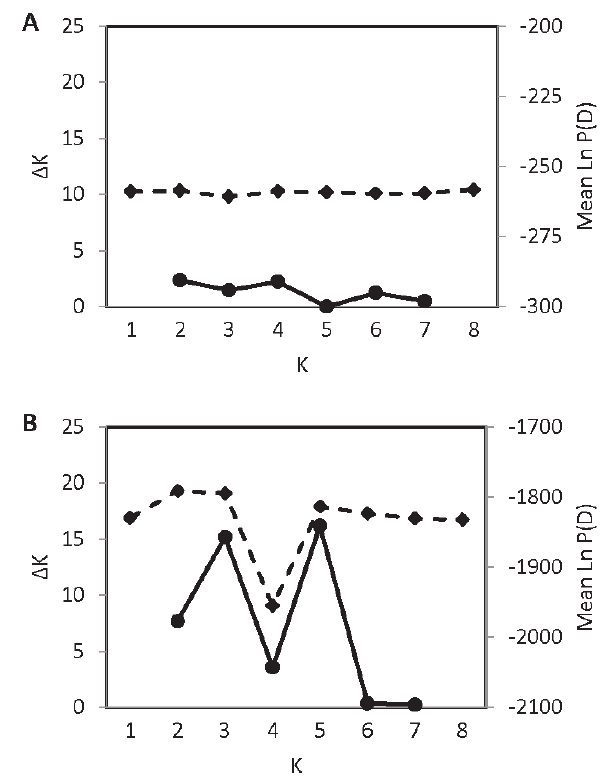
Figure 5. Absence of fine-scale population genetic structure in A ) N = 16 coyotes from Ohio, and B ) N = 113 coyotes from the northeast zone. See Figure 1 for zone